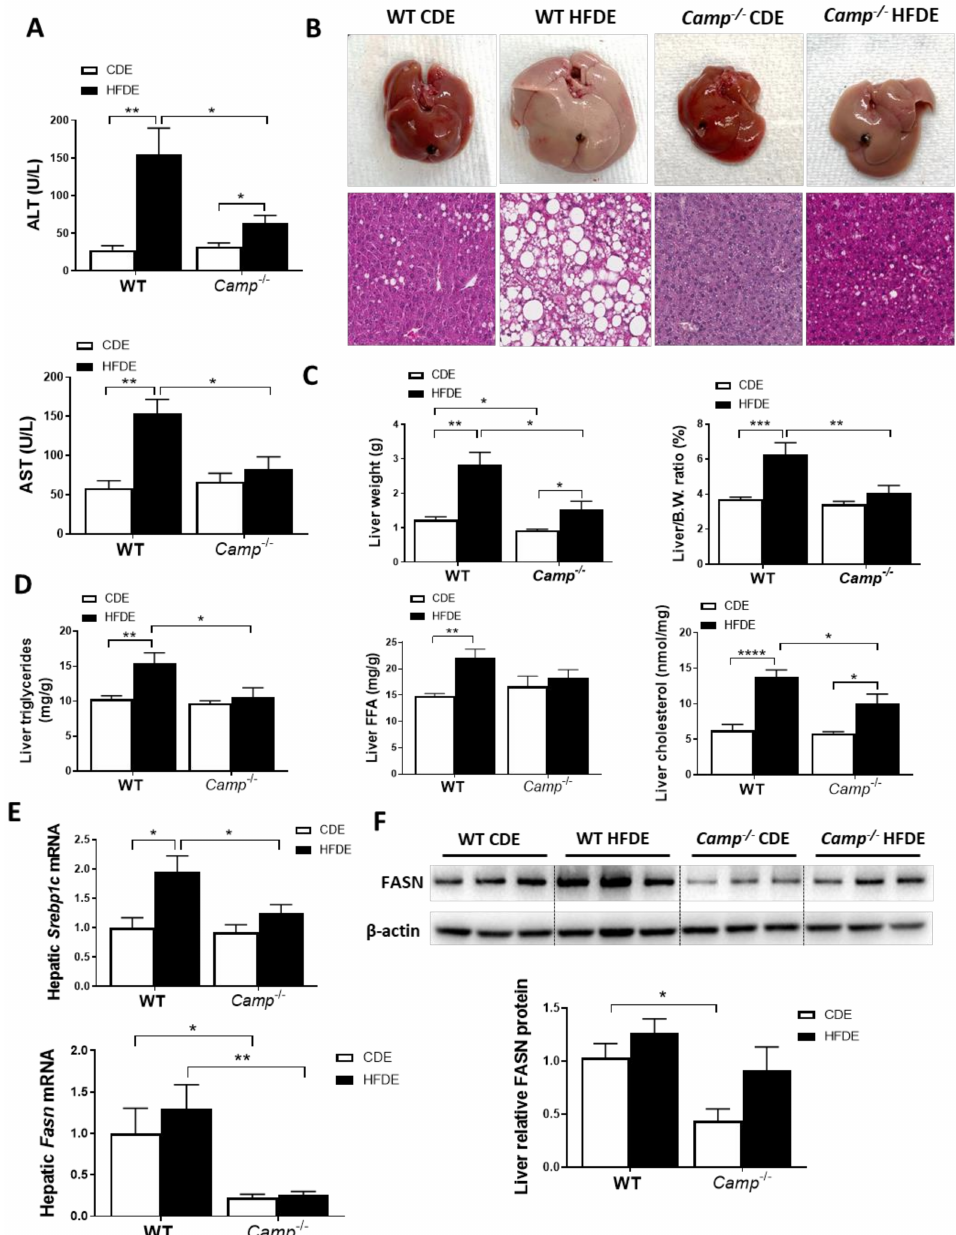
Figure 2. Camp –/– mice had significantly less injury and fat accumulation in the liver. ( A ) Serum ALT and AST levels. ( B ) Images of representative whole liver (upper panel) and microphotographs of H and E-stained mouse liver sections (lower panel). Magnification: 100 × . ( C ) Liver weight (left panel) and liver to body wight ratio (right panel). ( D ) Hepatic triglyceride, free fatty acid and total cholesterol levels. ( E ) Hepatic Srebp1c and Fasn mRNA levels. ( F ) Representative immunoblots of FASN protein in the liver tissue and quantification of relative protein expression to ACT β . Data are expressed in Mean ± SEM (n = 5 mice/group). * p ≤ 0.05, ** p ≤ 0.01, *** p ≤ 0.001, **** p ≤